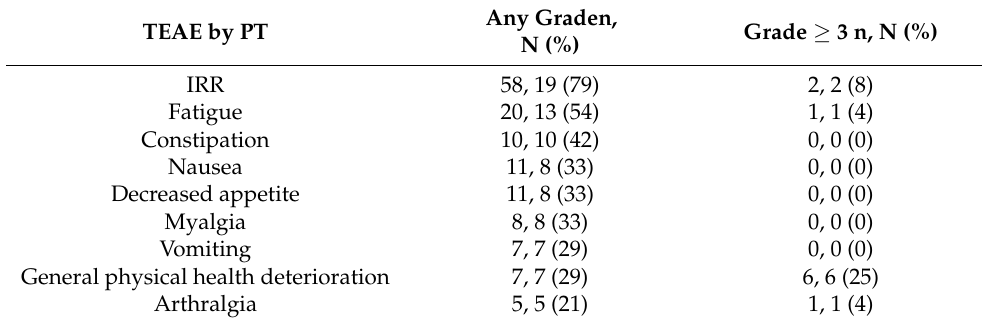
Table 2. Summary of treatment-emergent adverse events (TEAEs) in ≥ 20% of all patients (dose escalation plus safety expansion) by preferred term